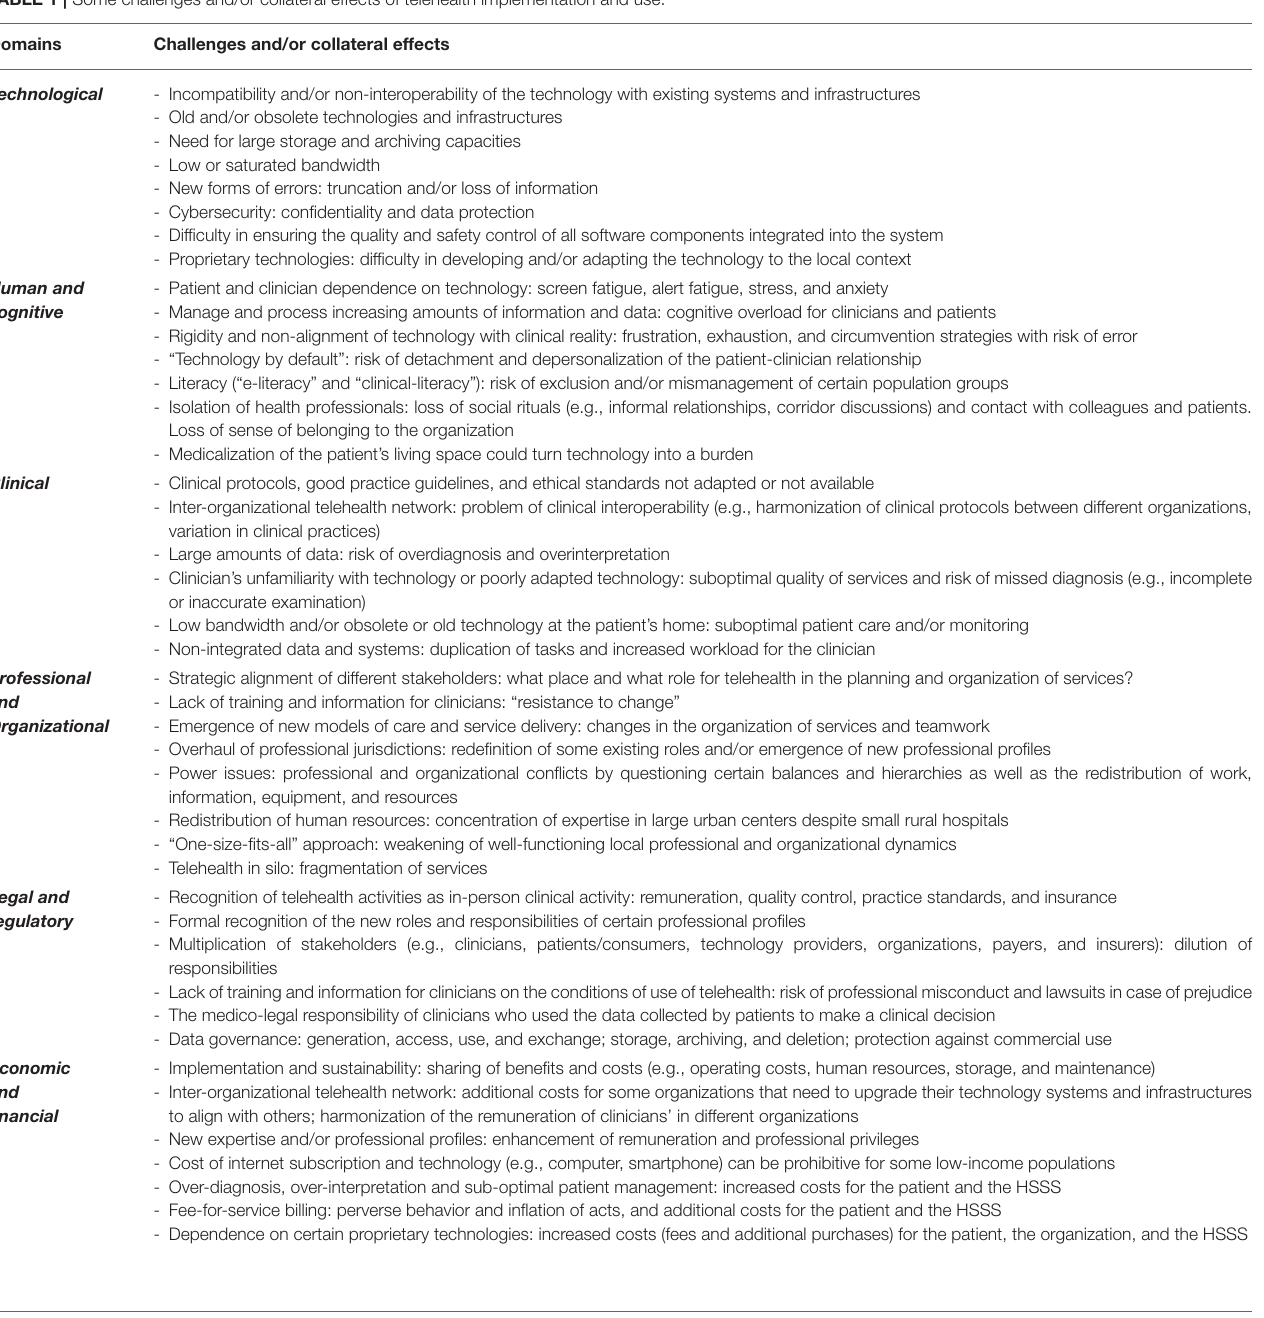
TABLE 1 | Some challenges and/or collateral effects of telehealth implementation and